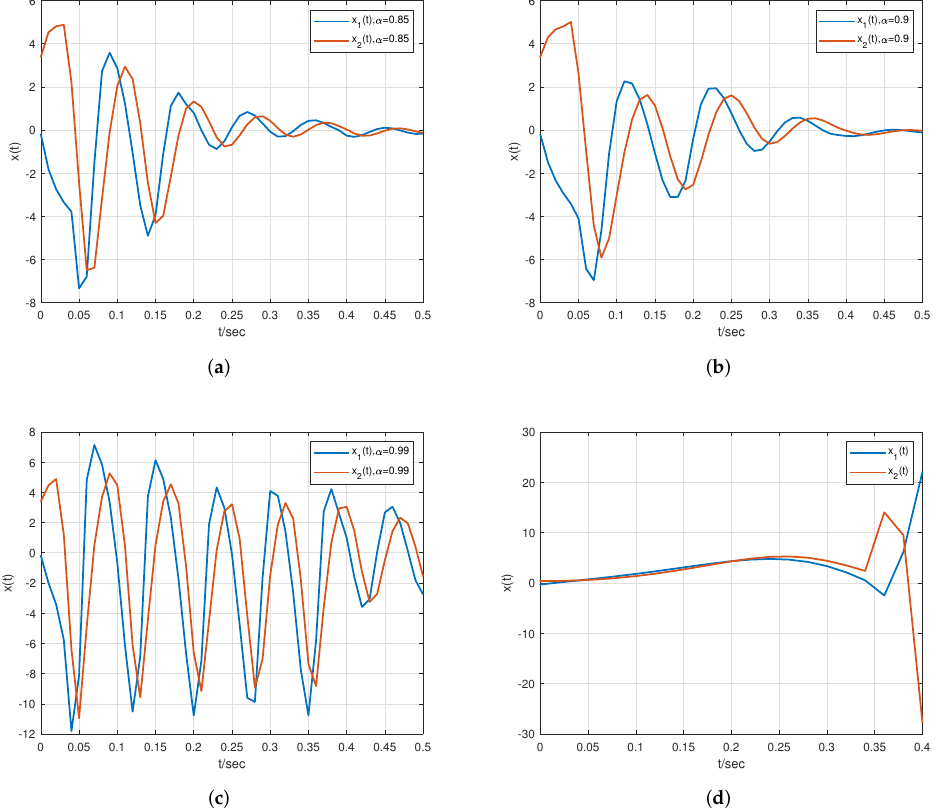
Figure 6. The panels ( a – c ) contain the curves of state variable x 1 ( t ) and x 2 ( t ) for ( Q − S − R ) dissipativity efficacy with distinct FO circumstances α = 0.85,0.9,0.99. Moreover, panel ( d ) is the trajectories of the open loop system in Example